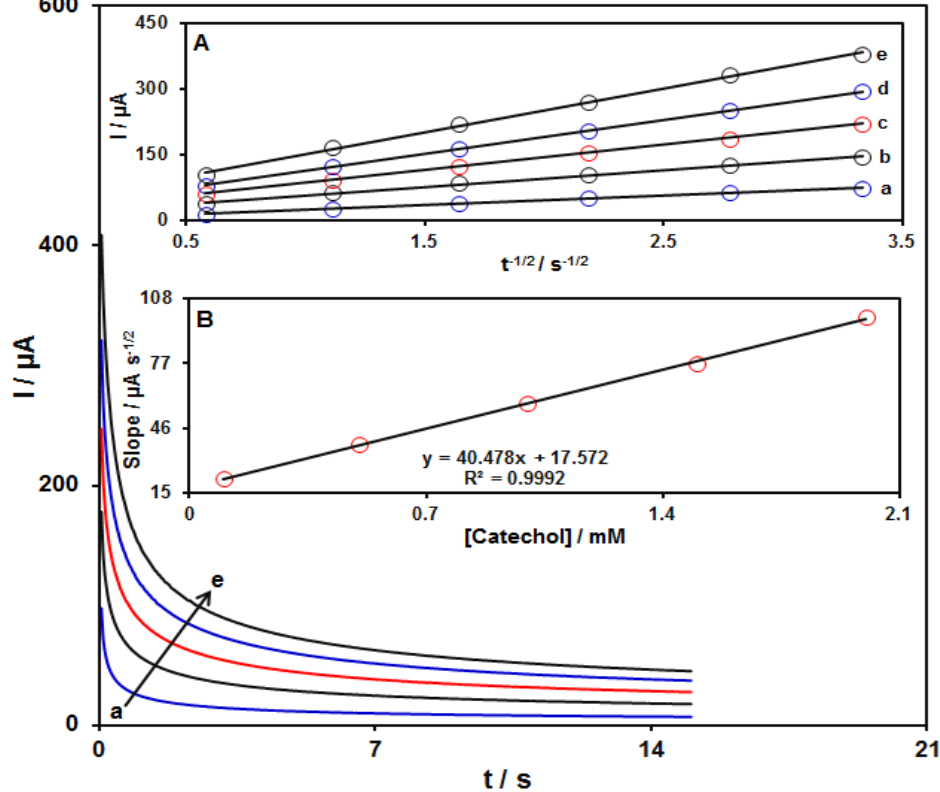
Figure 5. Chronoamperograms obtained on GO–PAMAM/ILCPE in PBS (0.1 M; pH = 7.0) at a potential of 295 mV for variable catechol concentrations (a: 0.1, b: 0.5, c: 1.0, d: 1.5, and e: 2.0 mM). Insets: ( A ) Variations of I vs. t − 1/2 taken from chronoamperograms and ( B ) plot of corresponding slopes against catechol concentration.